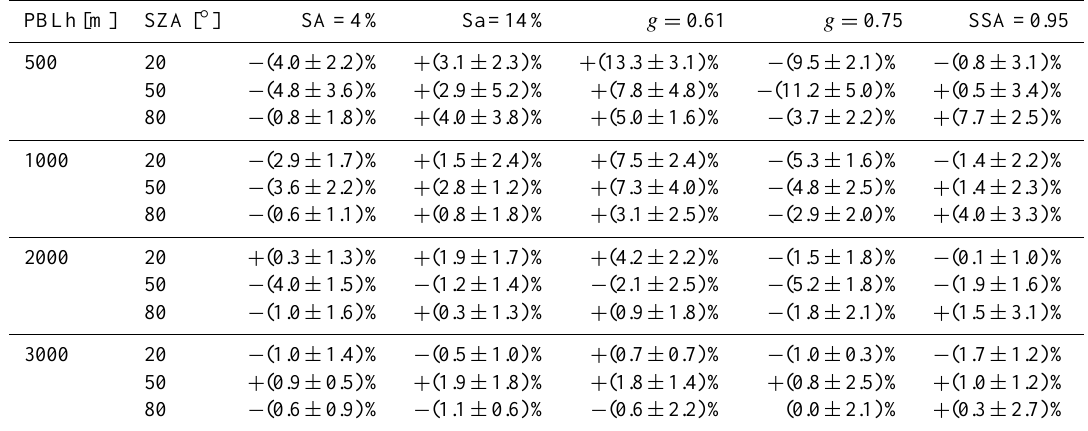
Table 1. Correction factor sensitivities to surface albedo (SA), asymmetry parameter g and single-scattering albedo (SSA) when modifying the corresponding parameter (default values: SA=9%; g = 0 . 68; SSA=0.78).